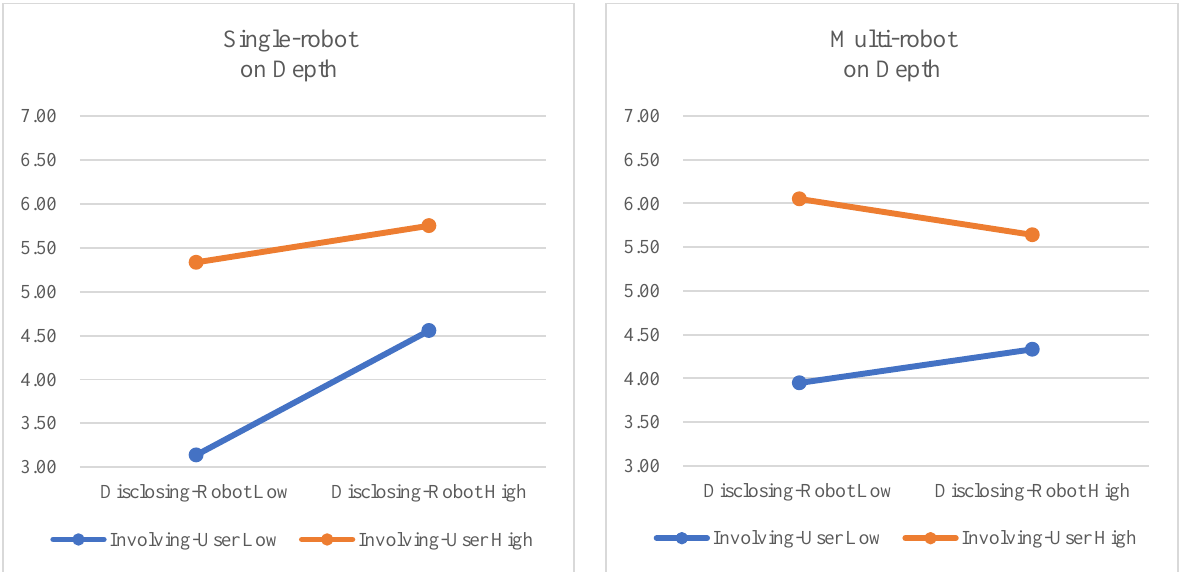
Figure 7. Interaction effects on depth (between IVs).